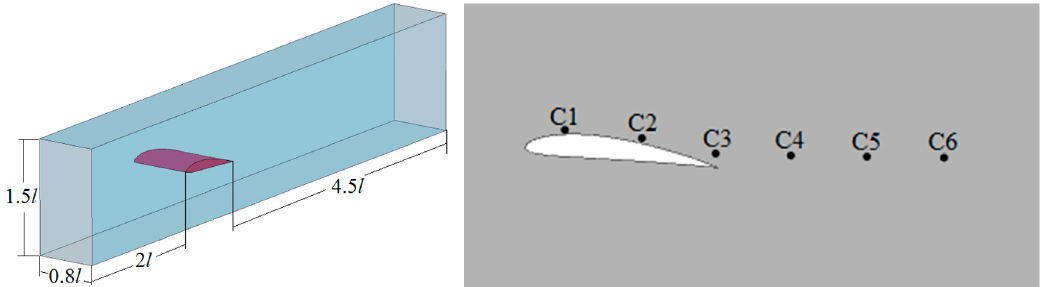
Figure 1. Geometry of 3D hydrofoil calculation domain and the distribution of monitoring point.